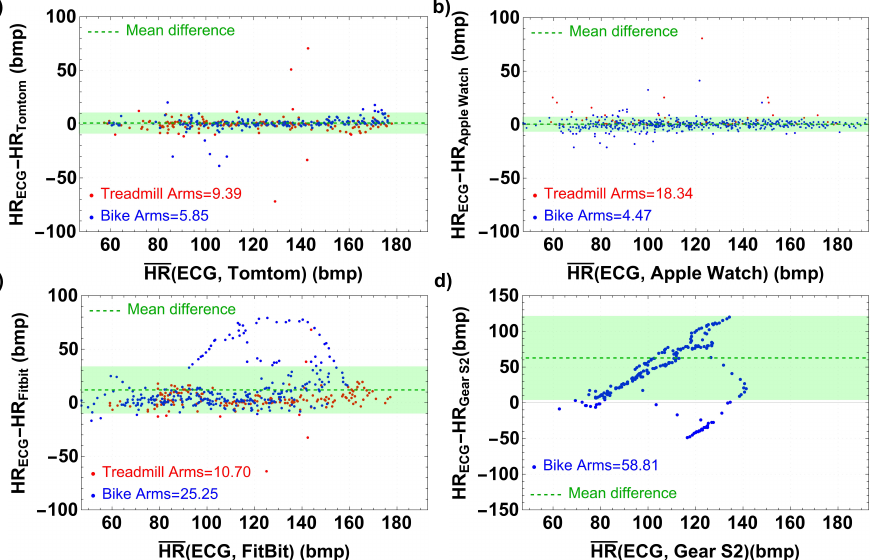
Figure 3. Bland–Altman diagrams of successive differences showing heart rate measurements for the four devices. The mean heart rate is shown on the x-axis and the difference between the specified device and the ECG rate is shown on the y-axis. Red dots correspond to the test on the treadmill and blue dots correspond to the test on the cycle ergometer. The green areas indicate the limits of the agreement. Panel ( a ) compares the TT runner and the ECG, Panel ( b ) compares the AW and the ECG, Panel ( c ) compares the FB Charge and the ECG, and panel ( d ) compares the G2 and the